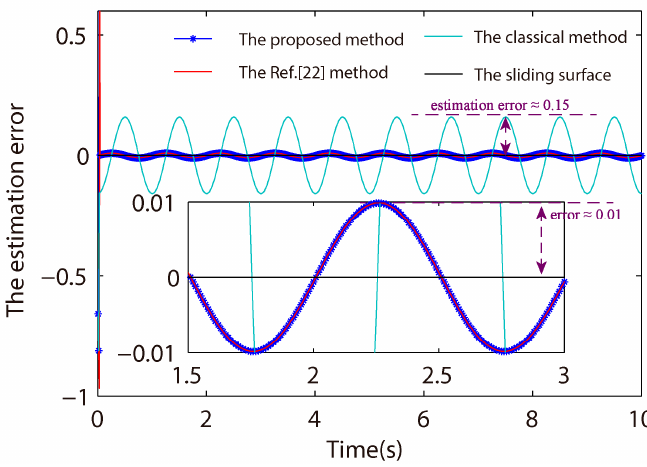
Figure 6. Disturbance estimation error contrast curve.